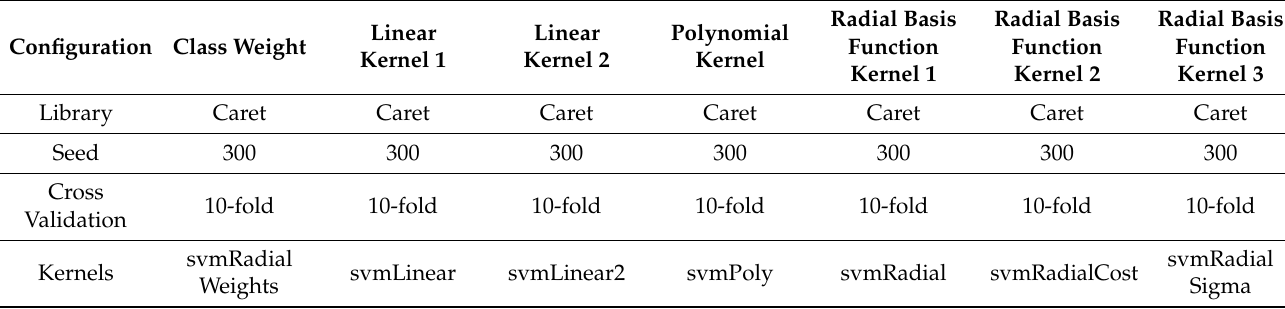
Table 5. SVM parameter